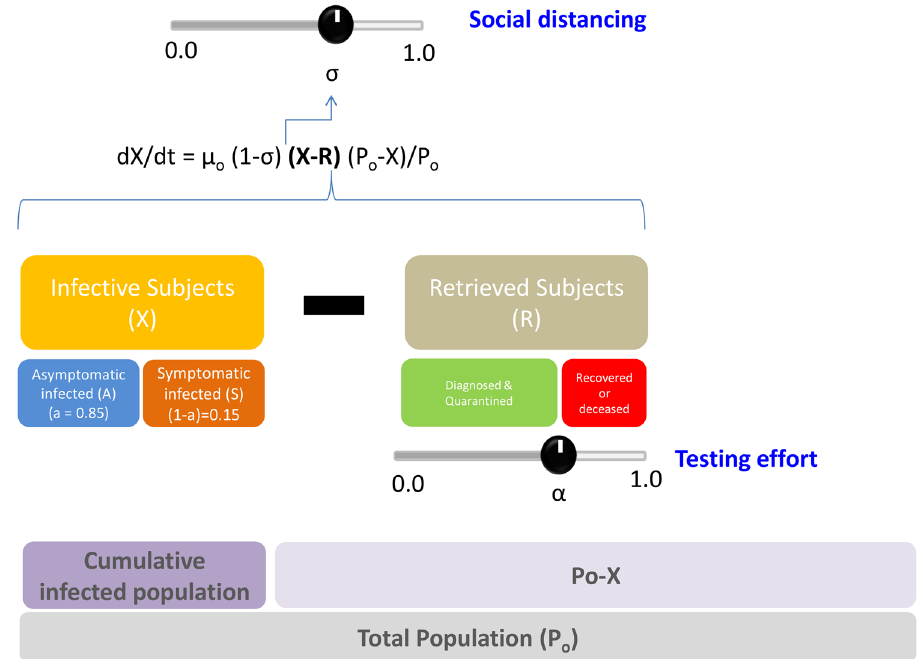
Figure 1. Model formulation. ( A ) Schematic representation of the model. This novel multi-compartment demographic model formulation considers that new infections are proportional to (X–R; infected-retrieved). Demographic elements are directly integrated into the model (P o , total population). The positioning and size of different bars indicates relationships between components. For instance, as the cumulative infected population progresses, the susceptible population (P o –X; total population minus infected individuals) is reduced. The social distancing (σ) and the testing effort (α) are explicitly stated as the two main parameters that modify the epidemic